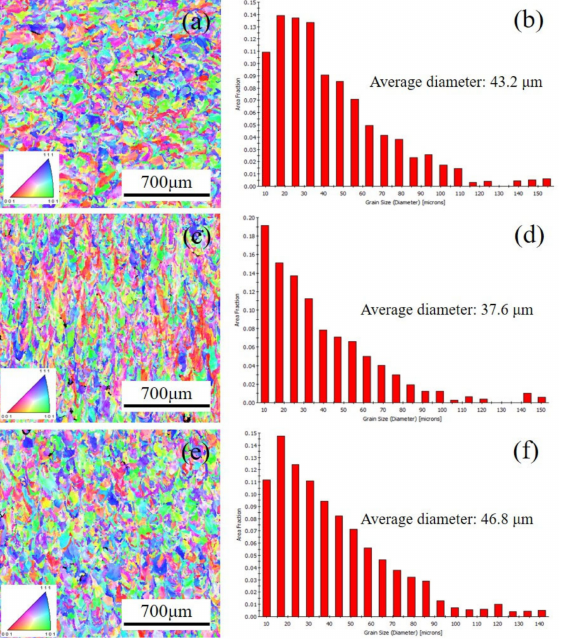
Figure 7. Grain orientation and size distribution of SLMed GH3536 before heat treatment: ( a , b ) transverse sample; ( c , d ) longitudinal sample; and ( e , f ) 45 ◦